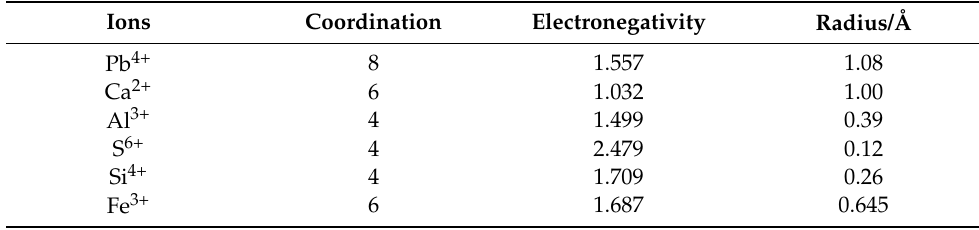
Table A3. Ions, coordination number, electronegativity, and ionic radius [38] of Pb and other ions that have been